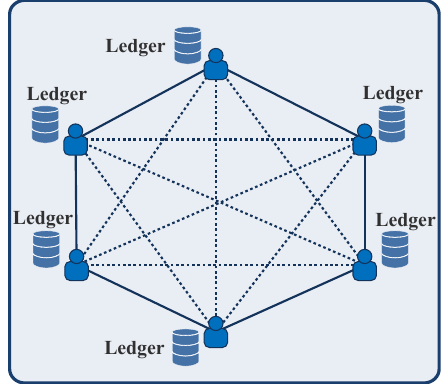
Figure 4. An example of blockchain